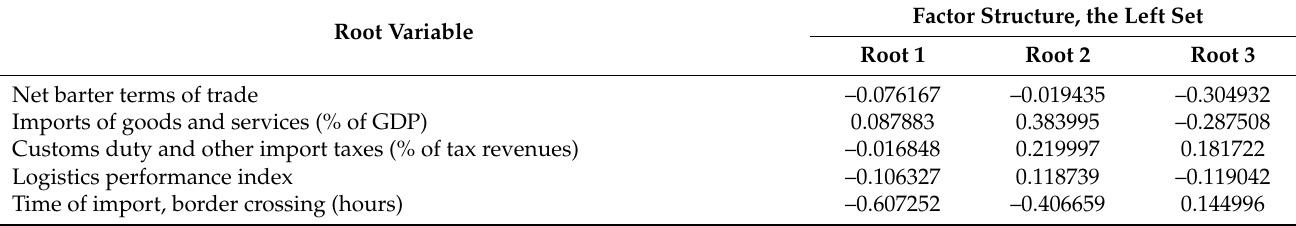
Table A3. Factor structure of the left set (set